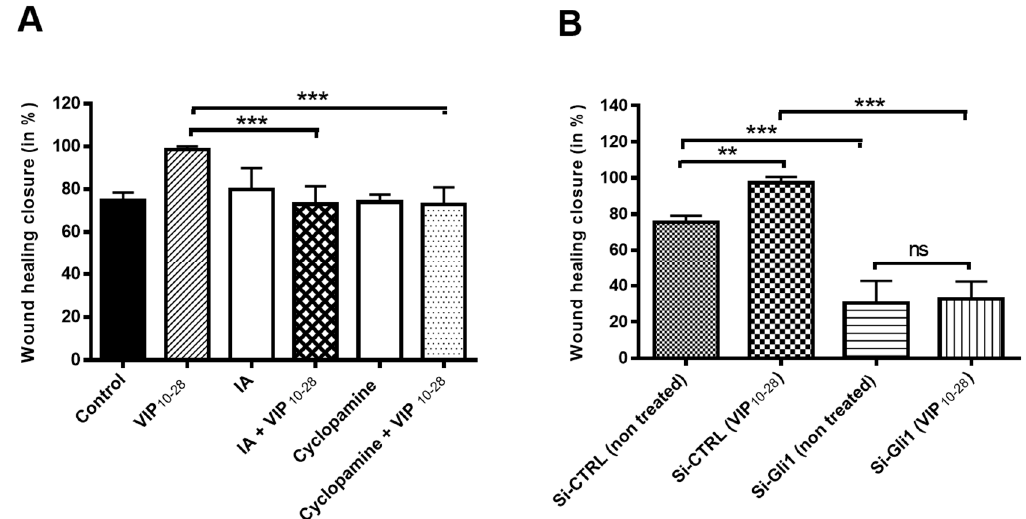
Figure 3. Effects of VIP 10-28 and/or inhibitors IA (Akt inhibitor), cyclopamine (Smo inhibitor), or Gli1 (Si-RNA) on the migration process of C6 cells. ( A ) Migration of C6 treated or not with VIP 10-28 at 10 -